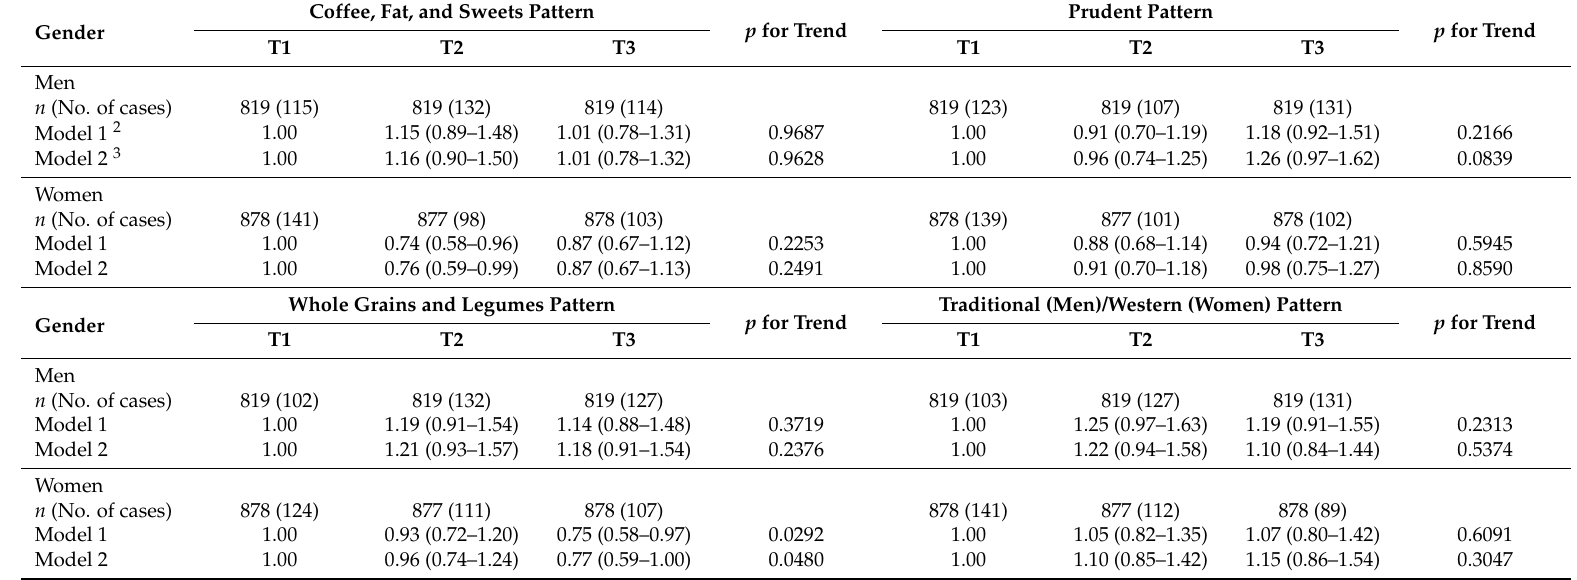
Coffee, Fat, and Sweets Pattern